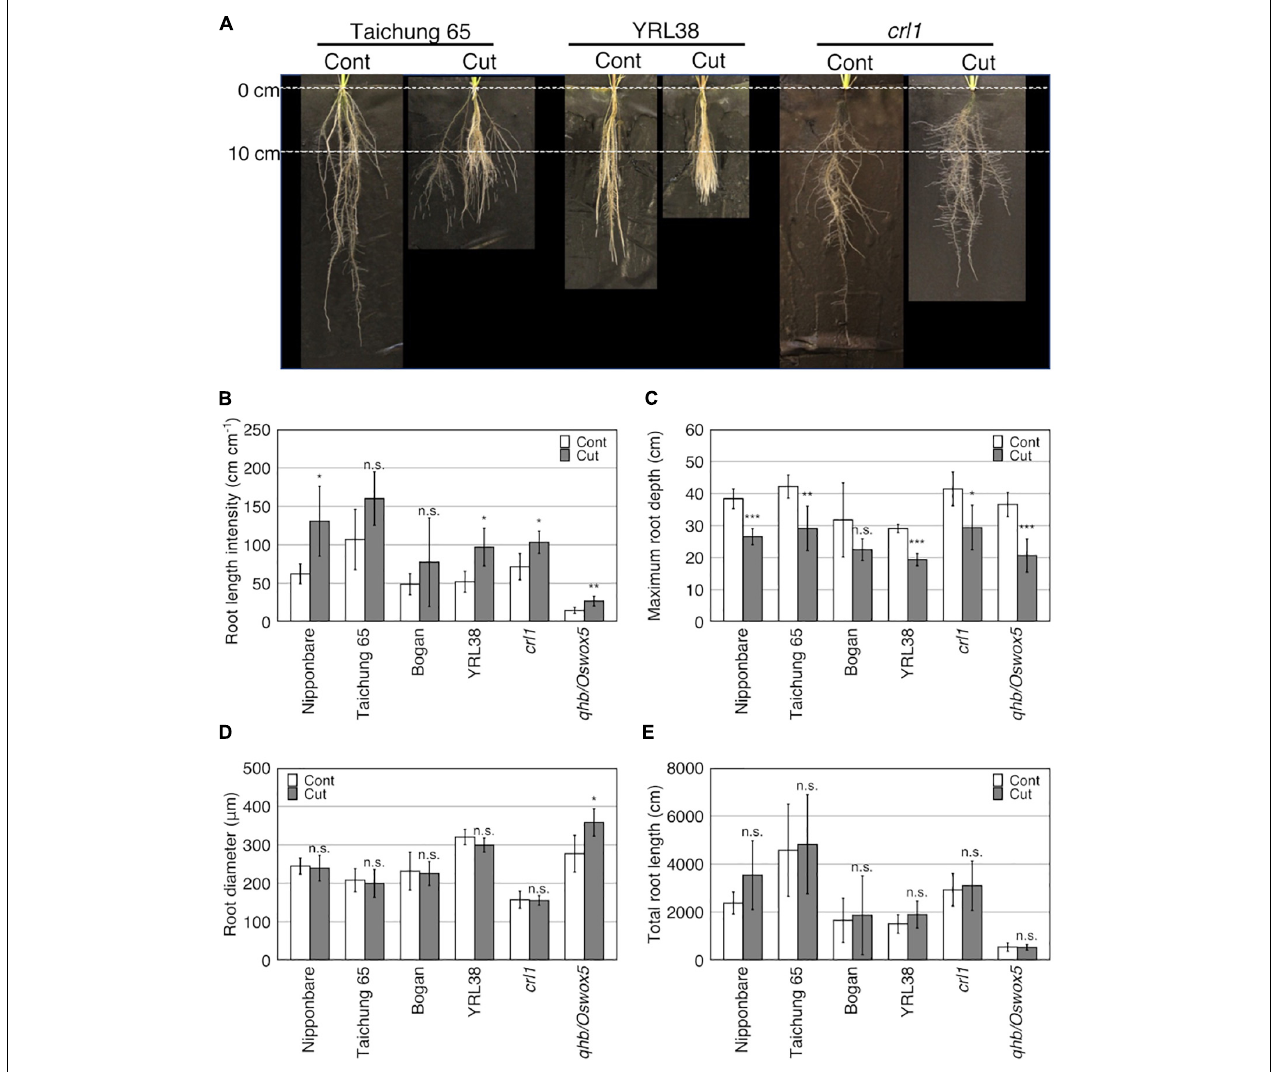
FIGURE 3 | Effect of root cutting treatment on root traits in six rice genotypes grown in a semihydroponic phenotyping platform for 41 days after transplanting (DAT). (A) Root phenotypes of three rice genotypes (Taichung 65, YRL38, and crt1 ) at 41DAT with cut (Cut) and without cut (Cont). (B–E) Effects of root cutting treatment on root traits. Values represent mean ± SD ( n = 3–6) (* p < 0.05; ** p < 0.01; *** p < 0.001; n.s., not